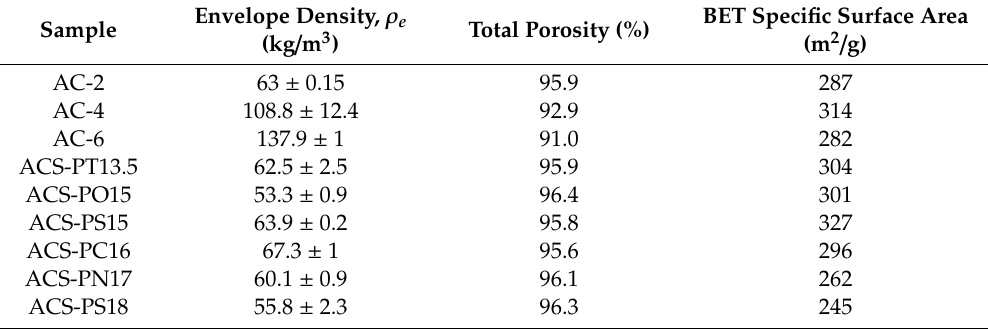
Table 1. Summary of the physical properties of cellulose materials. The skeletal density of cellulose II was taken from our previous report [16] which was about 1530 kg / m 3